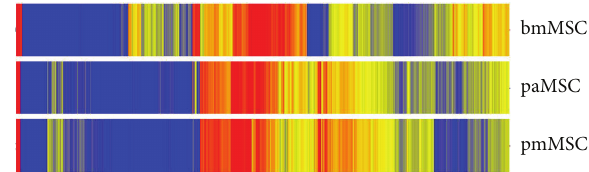
Figure 3: Comparing the total transcriptome of human MSCs from bone marrow (bmMSCs), from the amniotic site of human term placenta (paMSC), and from the maternal, endometrial part of human term placenta (pmMSC) in the second passage of in vitro expansion. MSCs from placenta are similar, but bmMSCs are clearly different from placenta derived